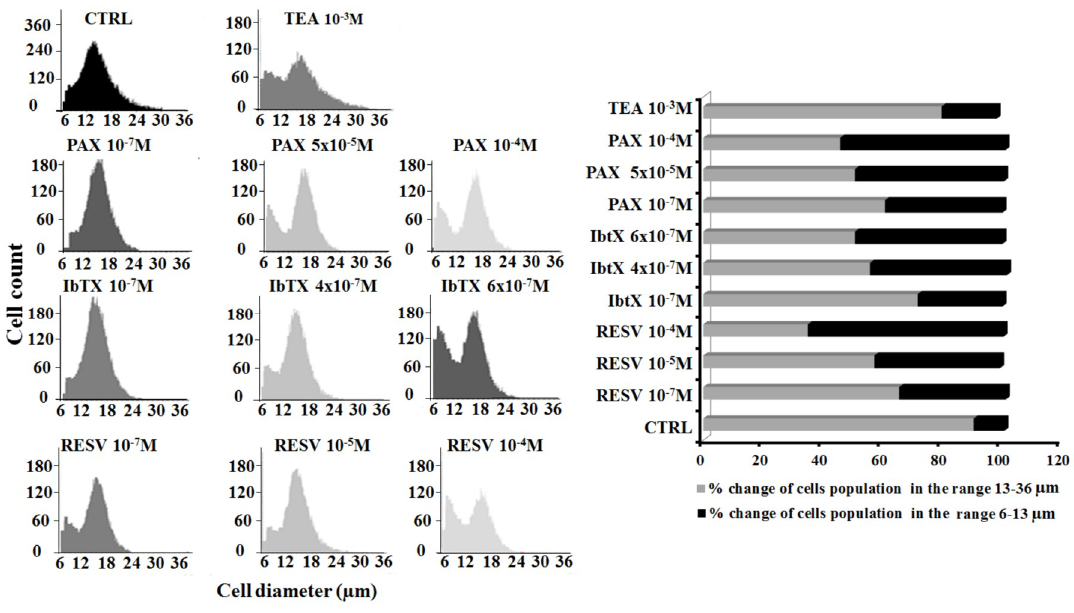
Figure 4. Gaussian type distribution of SH-SY5Y cells as a function of cell diameter size in the presence or absence of Kv/BK channel blockers: effects of the drugs on cell diameter after 6 h of incubation time. The effects of PAX (10 −7 , 5 × 10 −5 and 10 −4 M), IbTX (10 −7 , 4 × 10 −7 and 6 × 10 −7 M), RESV (10 −7 , 10 −5 and 10 −4 M) and TEA (10 −3 M) on cell distribution according to their diameter size were investigated in SH-SY5Y cells. The SH-SY5Y cell distribution follows a Gaussian curve when plotted as a function of their diameter size. Each graph is representative of cell distribution in a specific experimental condition. A biphasic distribution was observed after 6 h incubation time of cells with PAX, IbTX, and RESV. All compounds induced a concentration-dependent reduction of the cell numbers in the physiological diameter range of 13–36 µm for this cell type vs controls excepts TEA, while increasing the proportion of cell population in the diameter range of 6–13 µm.